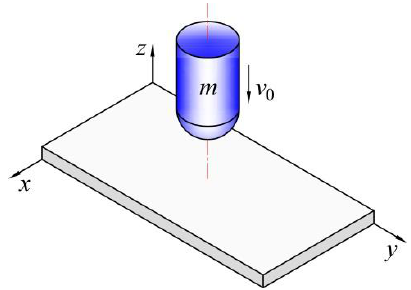
Figure 1. Transient analysis model of laminate and punch.